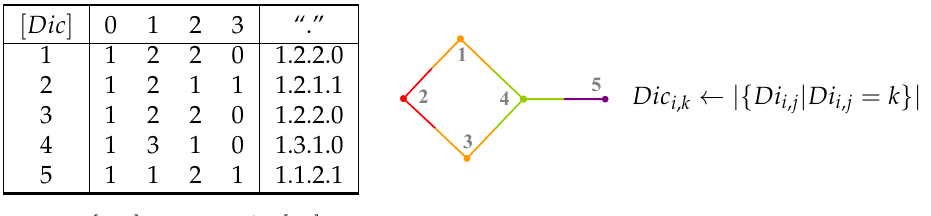
Figure 6. [ Dic ] (counting for [ Di ] ) on Figure 1.